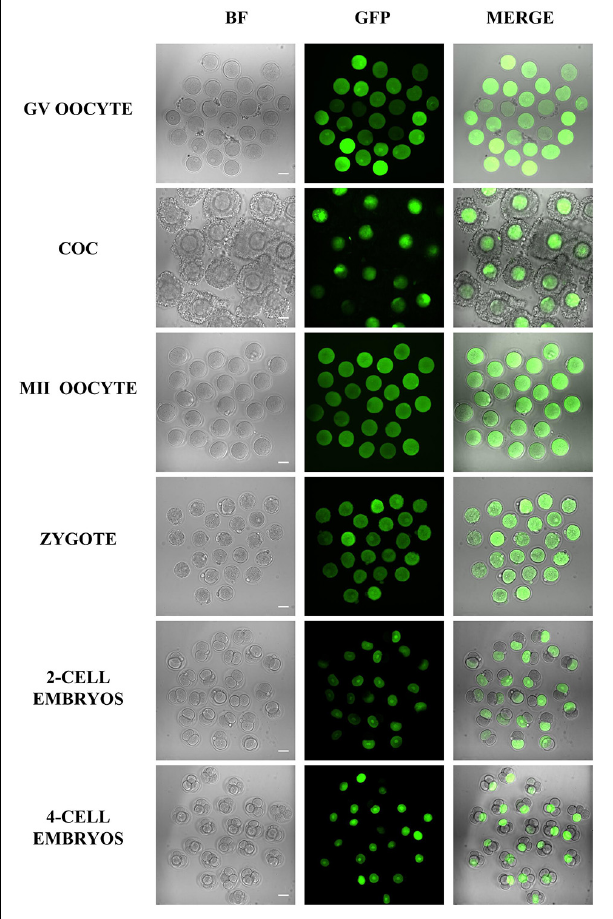
FIGURE 5 | Representative fluorescence images of oocytes and embryos after microinjection. Different oocytes and embryos were microinjected with GFP mRNA and imaged 5 h later. The results showed that all samples were successfully injected, and except for some COC and four-cell embryos that were not on the focal plane, most of the samples had similar GFP fluorescence. Bar = 50 µ